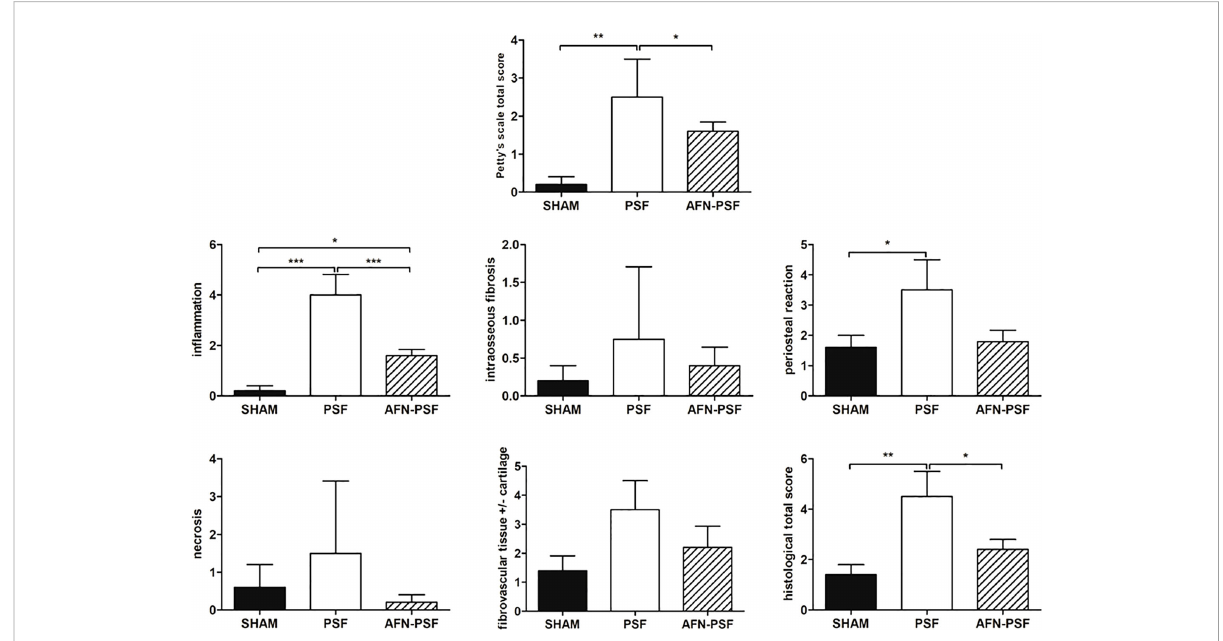
FIGURE 6 Semi quantitative histological score. The grading scores are reported in the histograms as human-based Petty ’ s scale for osteomyelitis signs in periosteum, cortex and medullary canal, as well as for in fl ammation, intraosseous fi brosis, periosteal reaction, bone necrosis, fi brovascular tissue +/- cartilaginous tissue, and total score based on a rat-speci fi c scale. Comparisons among groups were analyzed with one-way ANOVA corrected with Bonferroni ’ s post hoc test. Statistical signi fi cance was p < 0.05 (*), < 0.01 (**), and < 0.001 (***); n = 5 SHAM, n = 4 PSF, n = 5